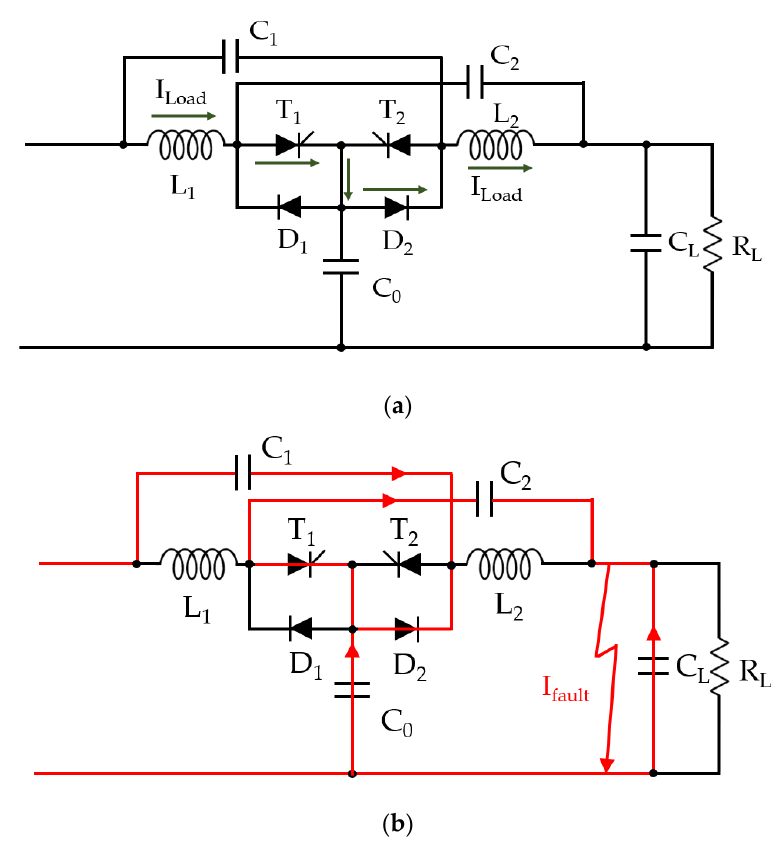
Figure 1. Bidirectional Z-source circuit breaker proposed in [27]: ( a ) normal conduction; ( b ) fault conduction.